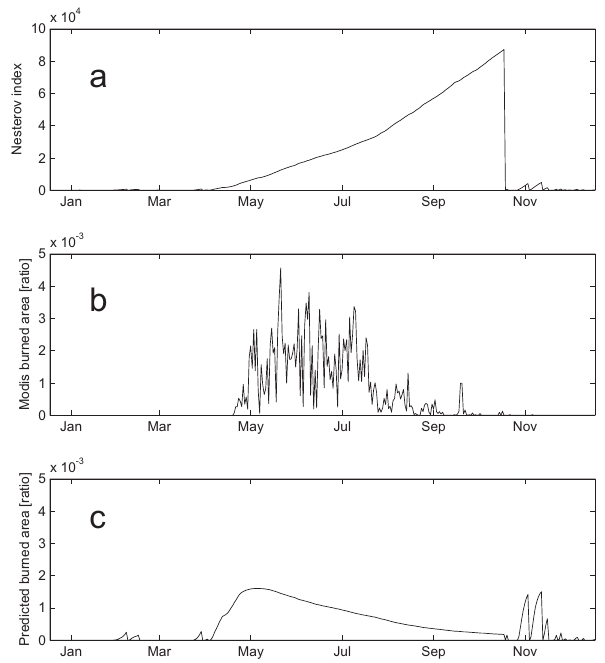
Fig. 8. Intra-annual wildfire activity. Temporal distribution of the Nesterov index (a) , the observed burned area (b) and the predicted temporal distribution of ratio burned (c) for an example gridcell ( − 12 ◦ S and 27 ◦ E) in the year 2007.